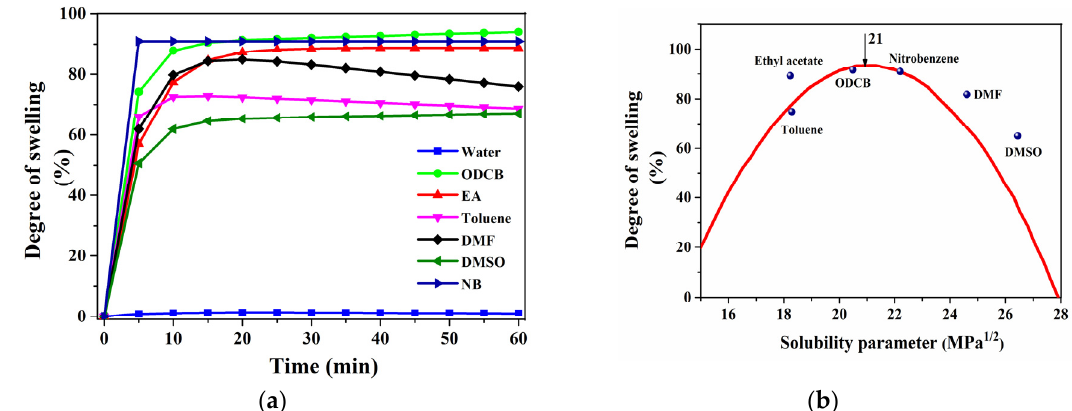
Figure 2. Saturation curve of PLLA in various organic solvents ( a ); Degree of swelling (%) Vs solubility parameter of various solvents (MPa 1/2 ) ( b ). Table 2. Data of solubility parameter of solvents and the degree of swelling of